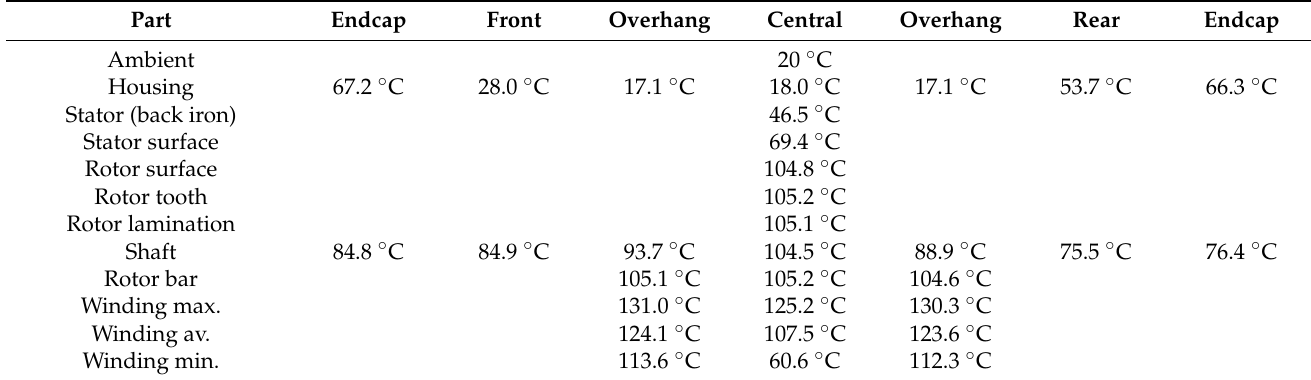
Table 16. Axial temperature graph for water-cooled motor with PA6GF30 casing.